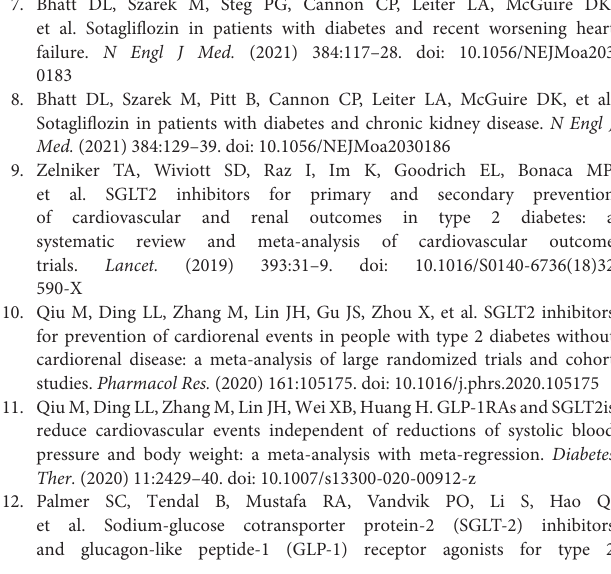
Supplementary Figure 1 | Publication bias detection for MACE (A) , CV death or HHF (B) , and CKO (C)